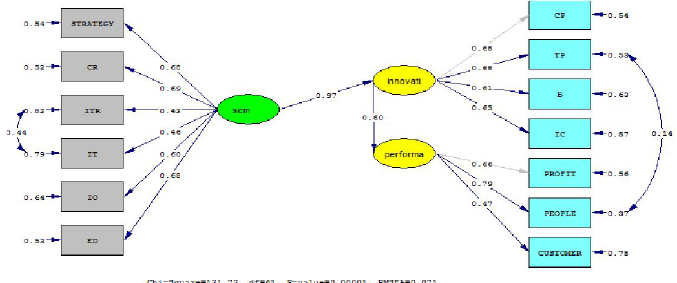
Fig. 1. The results of standard coefficients for the implementation of structural equation modeling